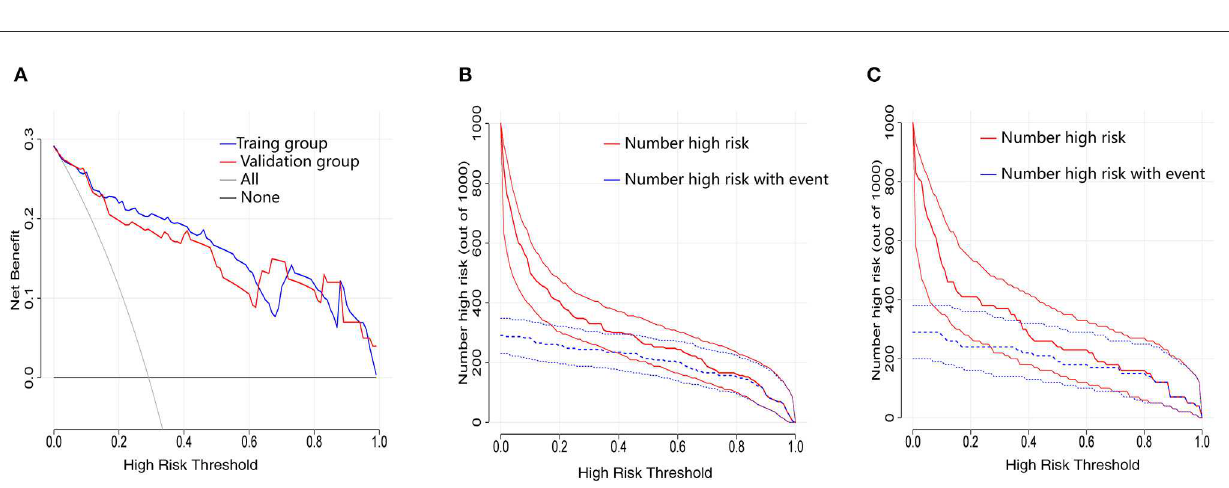
FIGURE4 Evaluation of the clinical utility of nomogram prediction models in the training and validation groups. (A) Decision curves in both the training and validation groups. (B) Clinical impact curve in the training group. (C) Clinical impact curve in the validation